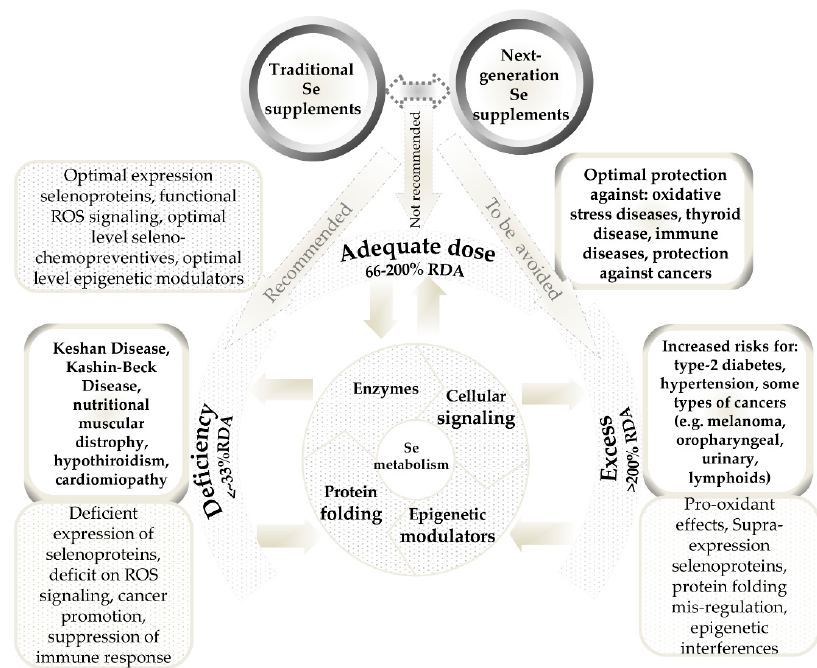
Figure 1. Physiological window of selenium supplementation. Intakes lower than recommended dietary allowance (RDA) determine diseases related to selenium deficiency. Intakes higher than 200% could lead to disorders related to excess selenium. The U-shape relationship between selenium and disease status limits selenium supplementation to subjects with lower-than-optimal selenium status. The next-generation selenium supplements, due to reduced toxicity and controlled release, should present a lower risk of supplementation on subjects with (near) Se optimal status. Data were obtained from References [5,23,43–47].